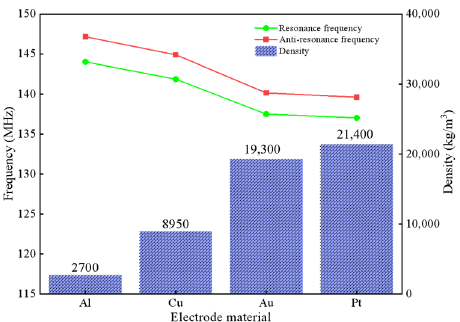
Figure 7. Different electrode materials-frequency characteristics.